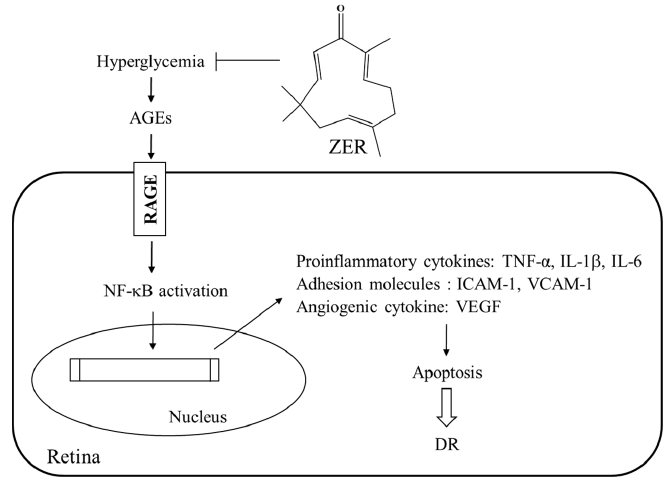
Figure 5. The possible action mechanisms of ZER on the amelioration of streptozotocin-induced retinal damage in rats. ZER showed the retinalprotective effects via reducing hyperglycemia to inhibit AGEs and RAGE axis, and thereby resulting in downregulation the expressions of proinflammatory cytokines, adhesion molecules and angiogenic cytokine, that in turn retards apoptosis, and consequently lessens damage in diabetic retinal